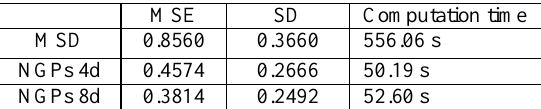
Table 3. Statistics of mean-square error (MSE) and standard division (SD) of the height differences between MSD and NGPs compared with the LiDAR DTM as well as the time required to execute the algorithms.